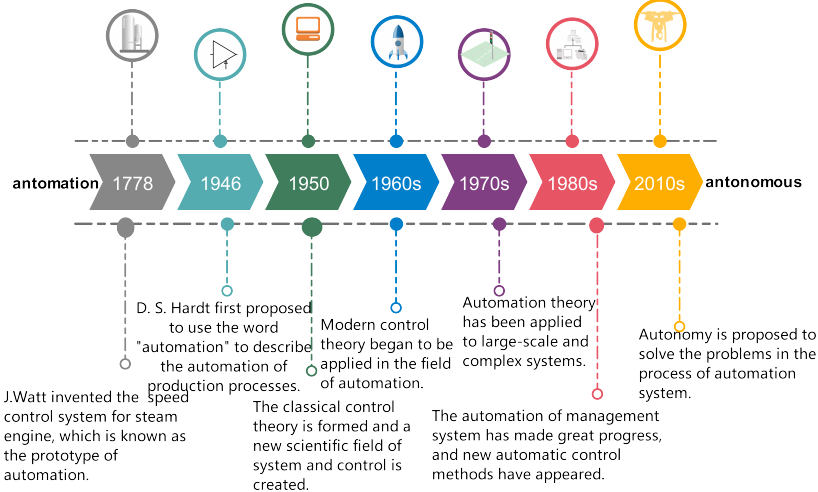
Figure 1. The development of individuals and systems from automation to